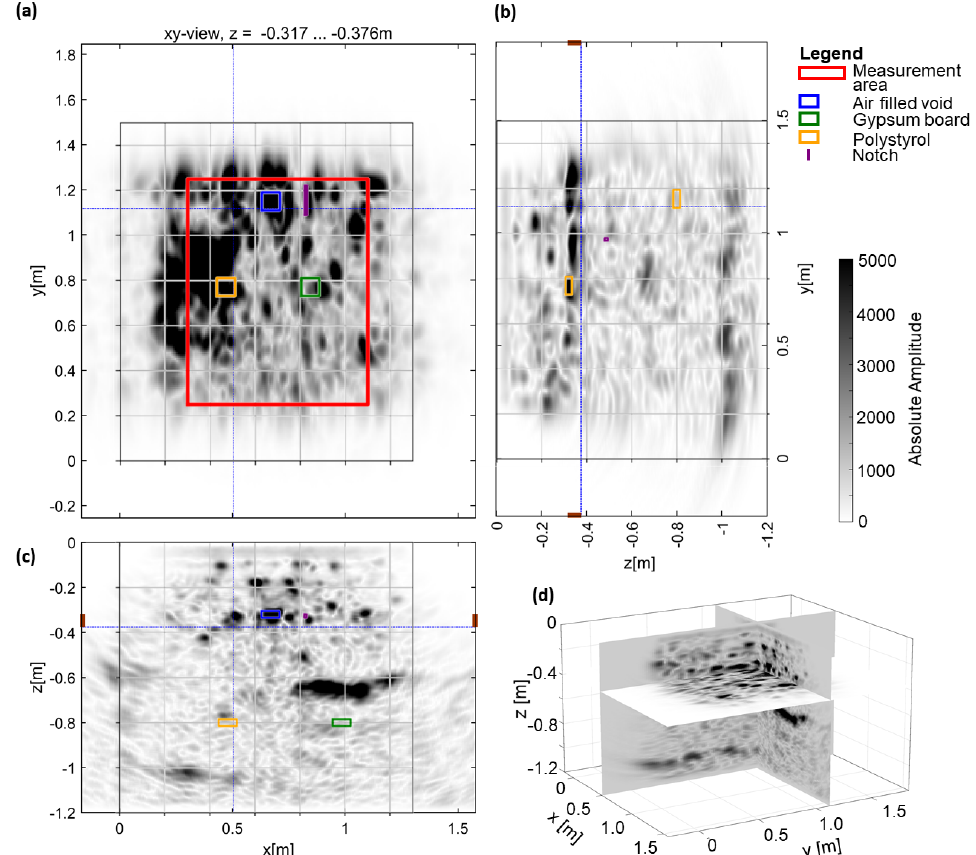
Figure 9. Ultrasonic imaging results of GSBV4 overlain by expected location of artificial defects (com- pare Figure 8): ( a ) xy–slice at z = − 0.32 m, ( b ) yz–slice, ( c ) xz–slice, and ( d ) 3D view at marked